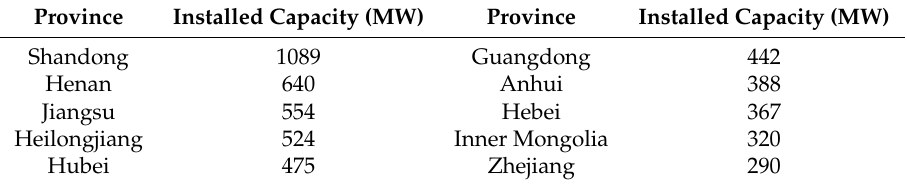
Table 1. Installed capacity in the top ten provinces of the Chinese biomass power industry as of 2013 [54].